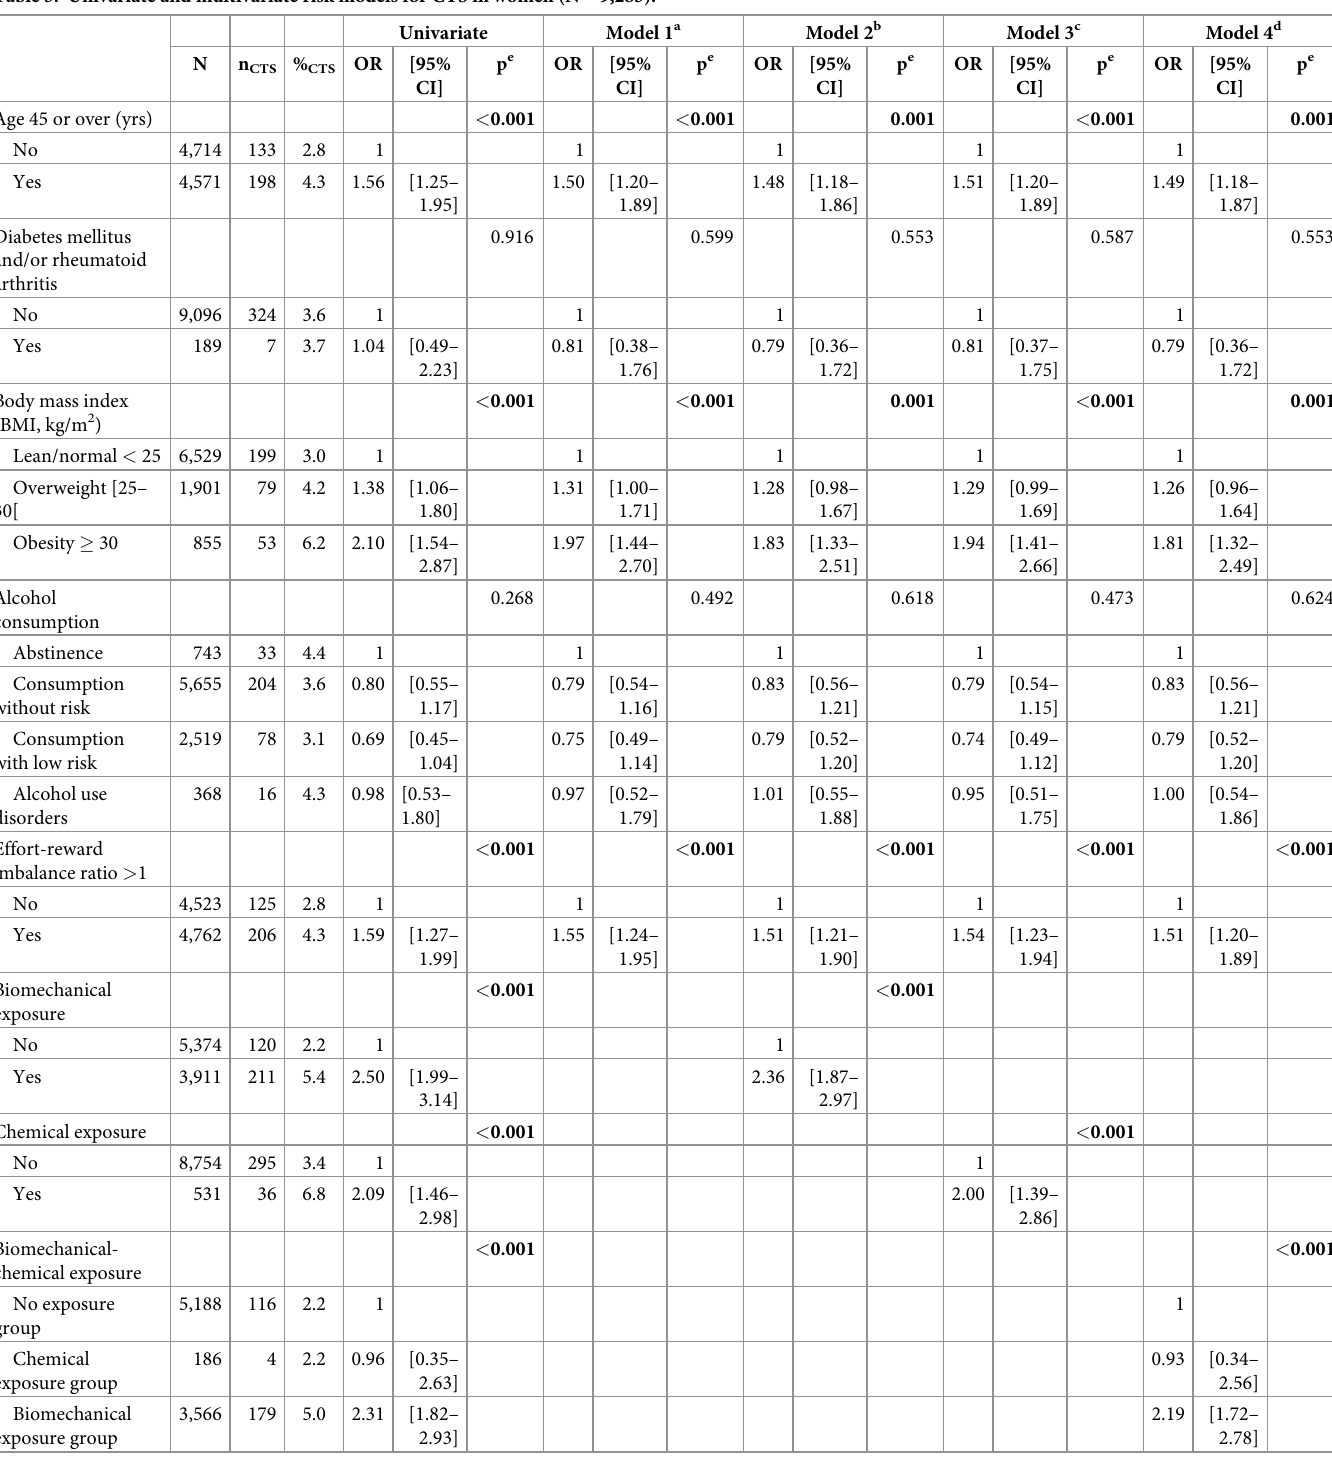
Table 3. Univariate and multivariate risk models for CTS in women (N =